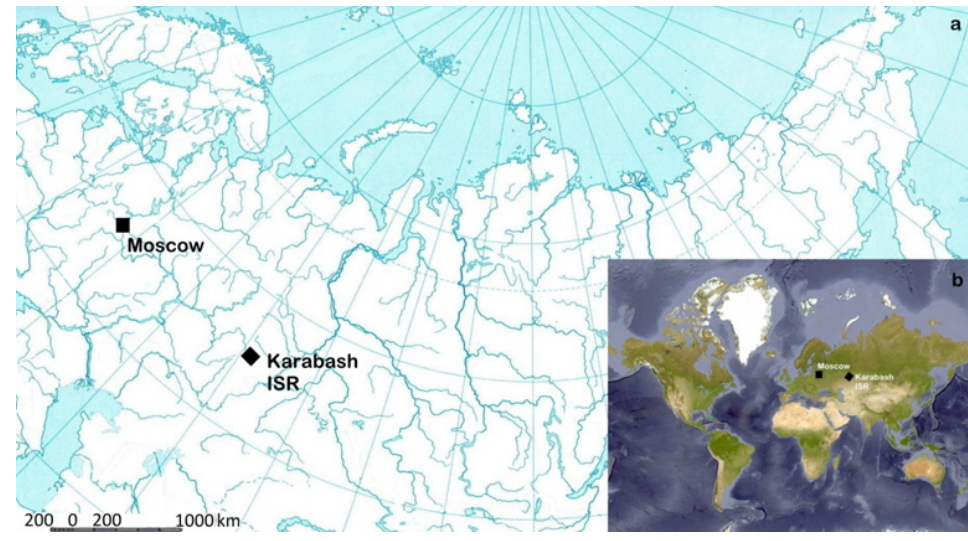
Figure 1. Location of the study area: ( a ) in Russia and ( b ) in the world. (https://www.google.ru/maps)